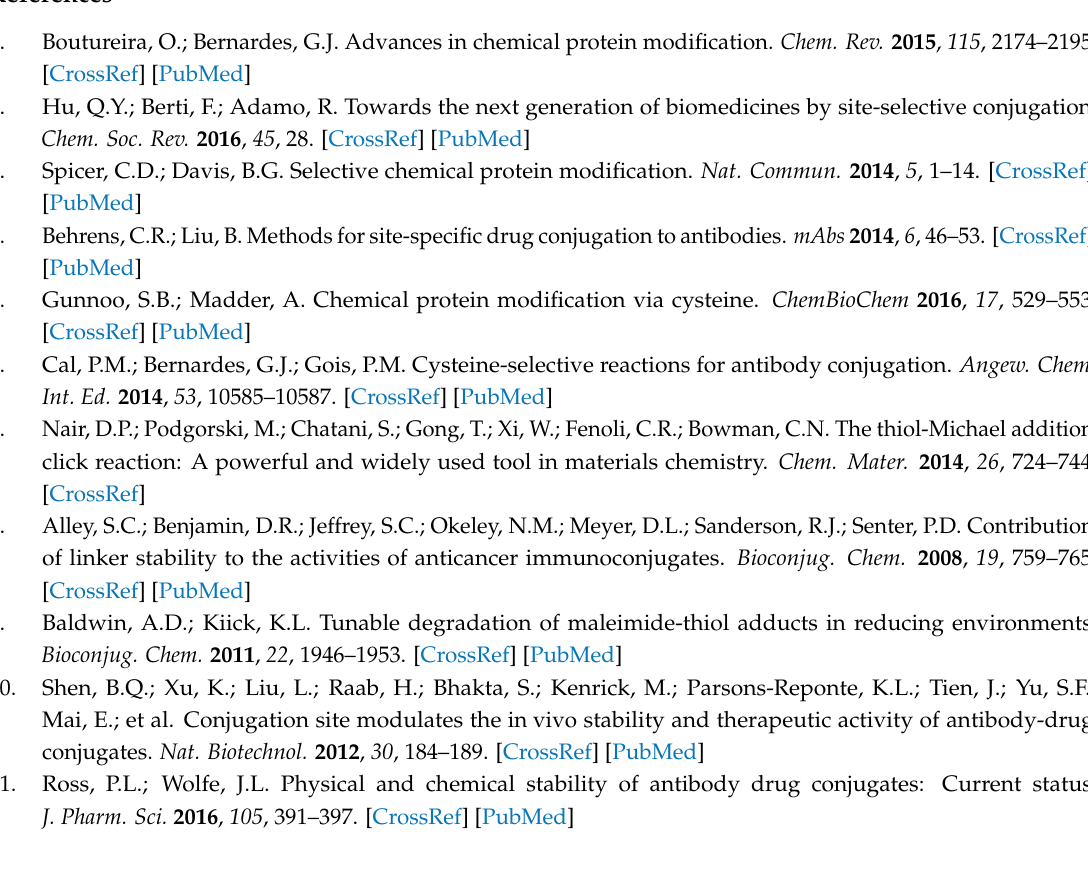
Figure S1: Representative SEC trace (IgG control T289C SG3376) showing peaks used to determine monomer content in ADCs, Figure S2: Identity and mass of species remaining conjugated to antibodies following linker cleavage in cleavable PBD drug-linkers, Figure S3: Mouse serum stability and tumor growth inhibition activity of A07-108 ADCs prepared with C239i cysteine engineered